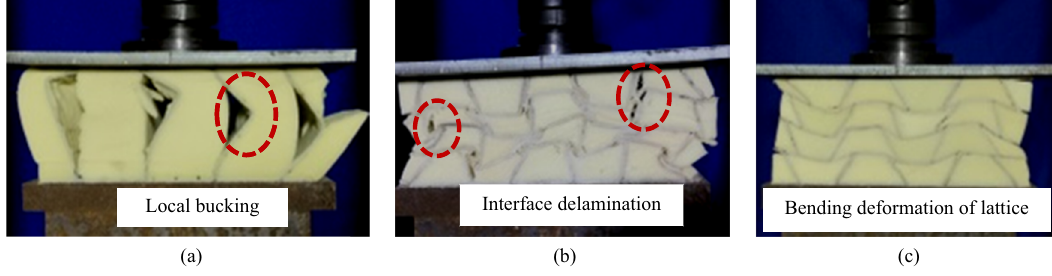
Figure 9: Failure modes of specimens: ( a ) local bucking, ( b ) interface delamination, ( c ) bending deformation of